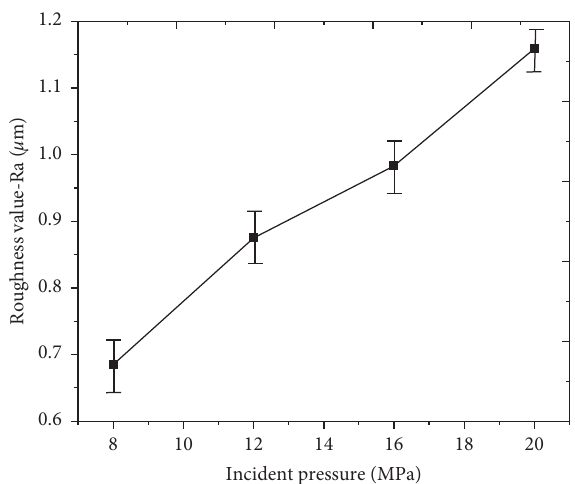
Figure 7: Surface roughness of formed components in the bottom region under different incident pressures.